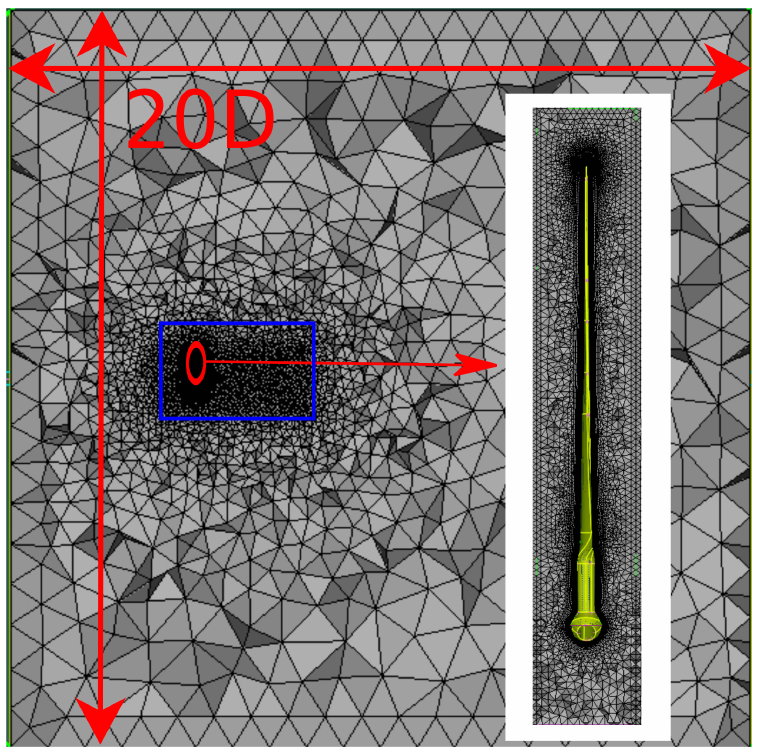
Figure 5. Lateral view of the purely Eulerian